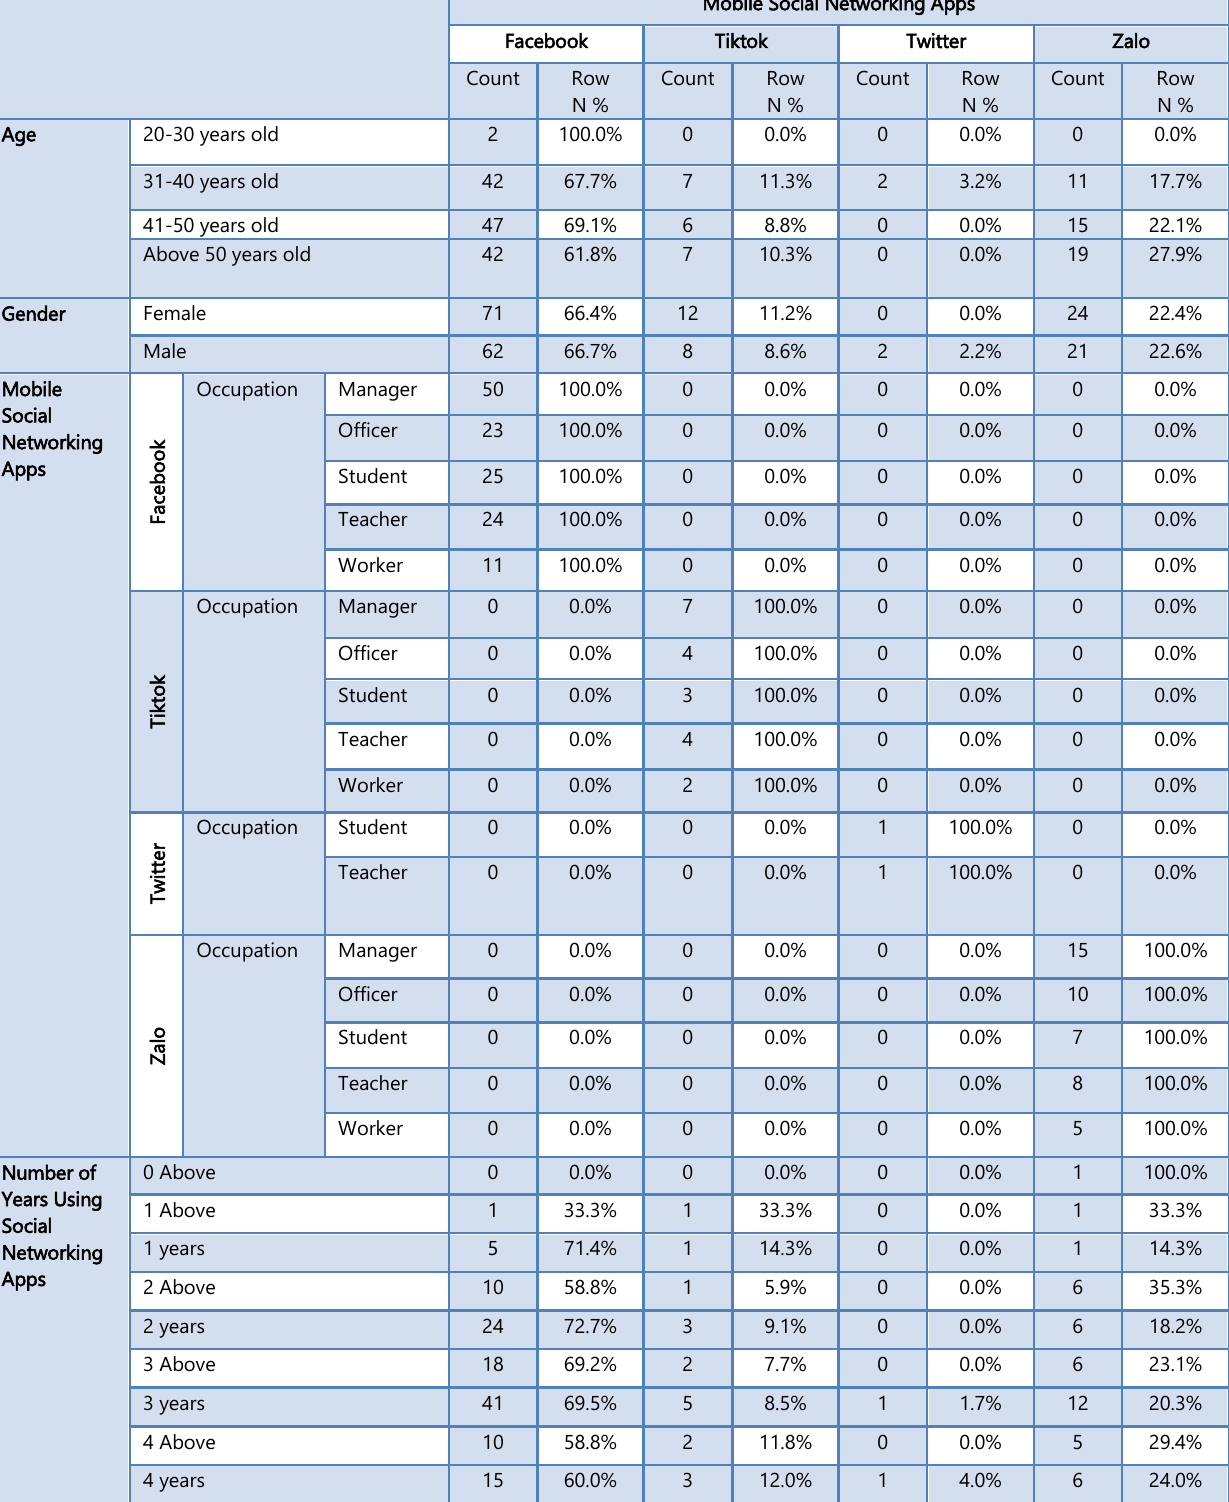
Mobile Social Networking